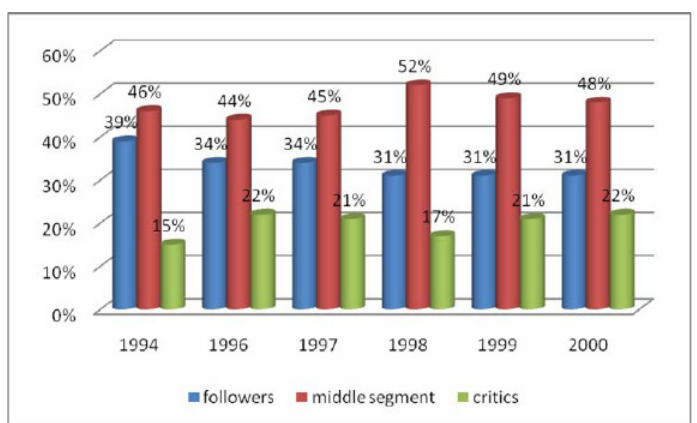
Figure 2 Segments of attitude towards